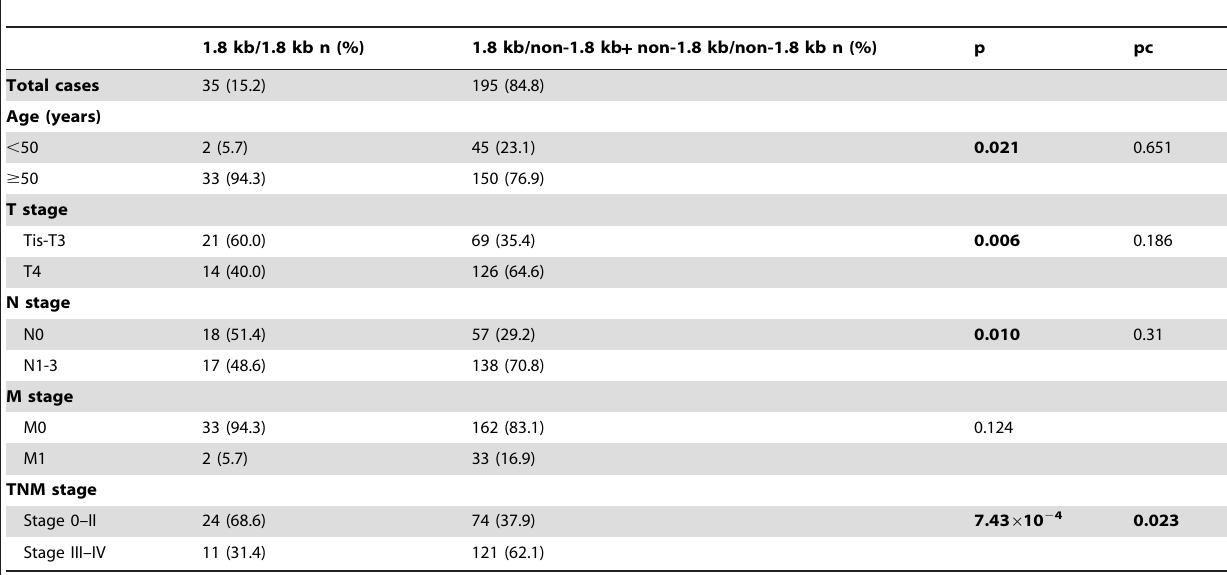
Table 4. Clinical and pathological characteristics of GC patients with MUC5AC-u repetitive region 1.8 kb